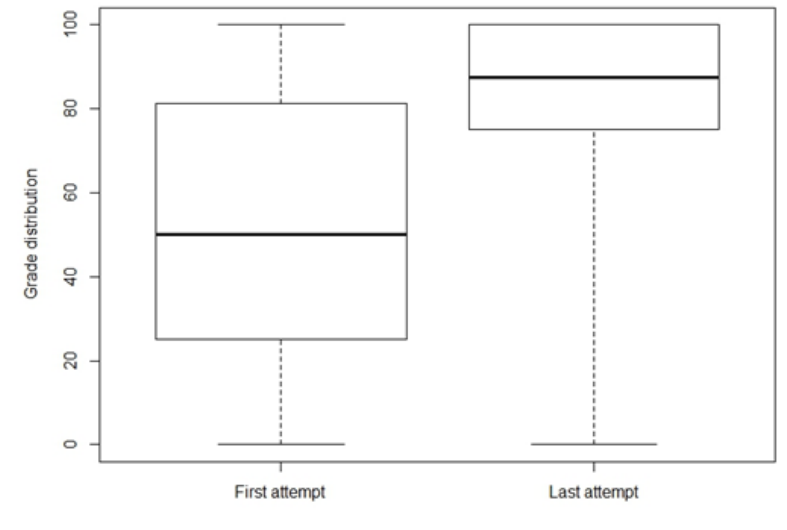
Figure 2. First attempt vs. last attempt on the last online quiz – Student